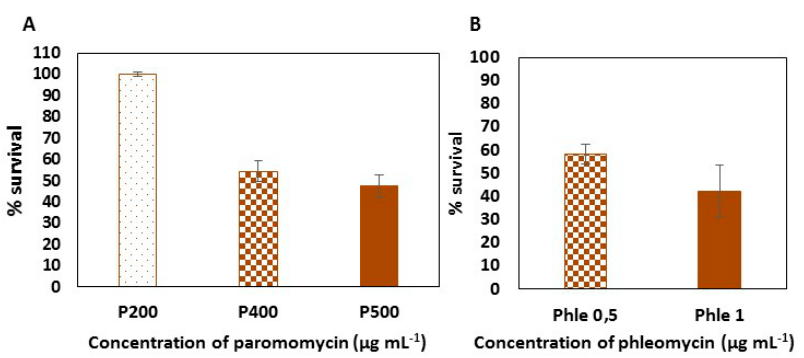
Figure A2. Average survival Chlamydomonas clones transformed with the plasmid Phyco69BLE and cultured with increasing concentrations of paromomycin ( A ) or phleomycin ( B ). Values are the average of at least three replicates and bars represent the standard deviation.